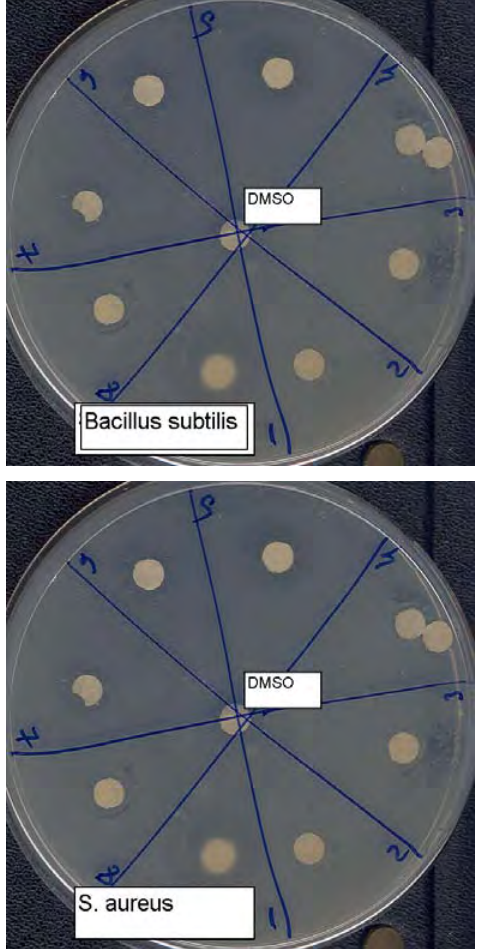
Figure 1. The aspect of inhibition zones obtained for the tested compounds on different pathogens in the qualitative screening assay by the adapted Kirby- Bauer